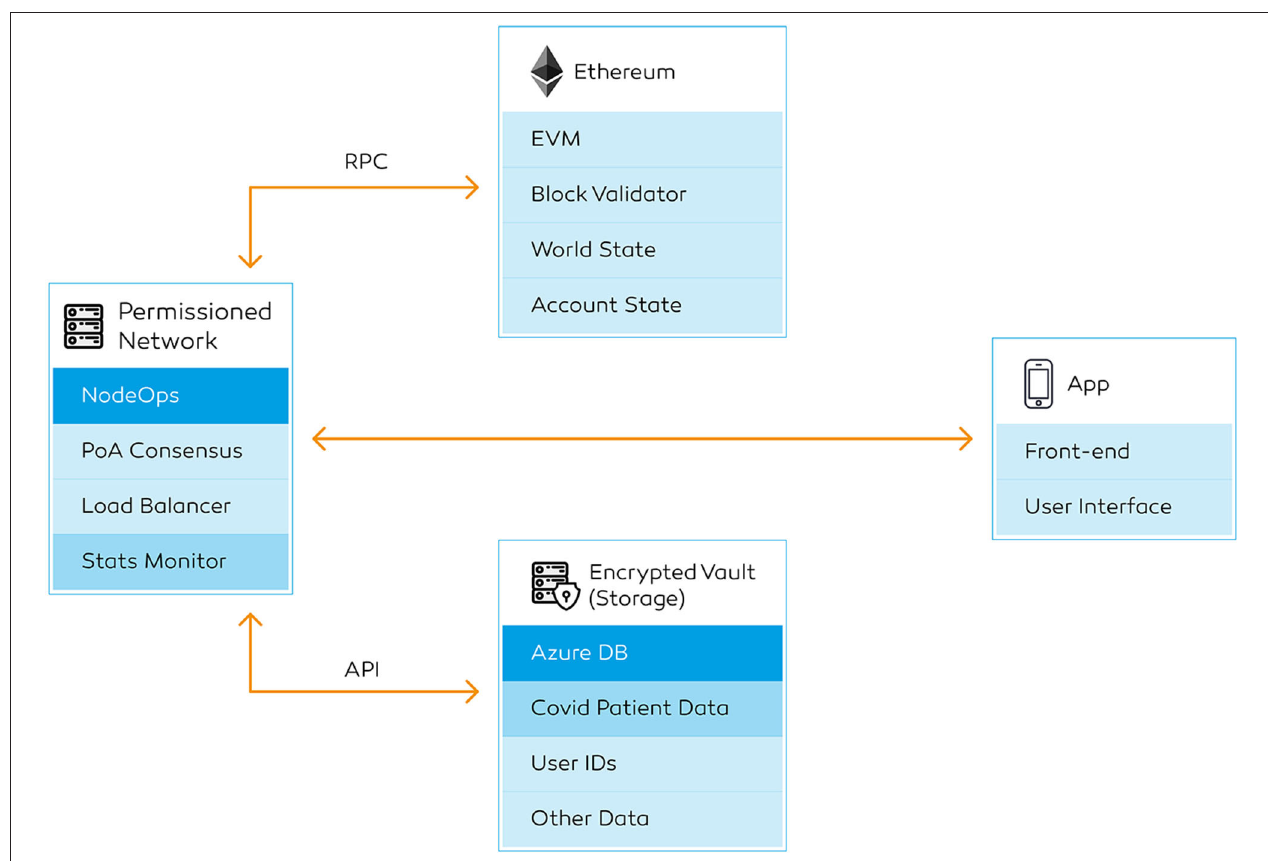
FIGURE 3 | High-level backend workflow. Transaction detail page showing a successful deployment. It contains the transaction hash, sender’s and receiver’s public keys, block number, timestamp for the block, and the input data. The users can keep a copy of the transaction hash, which is an alternative to an “order